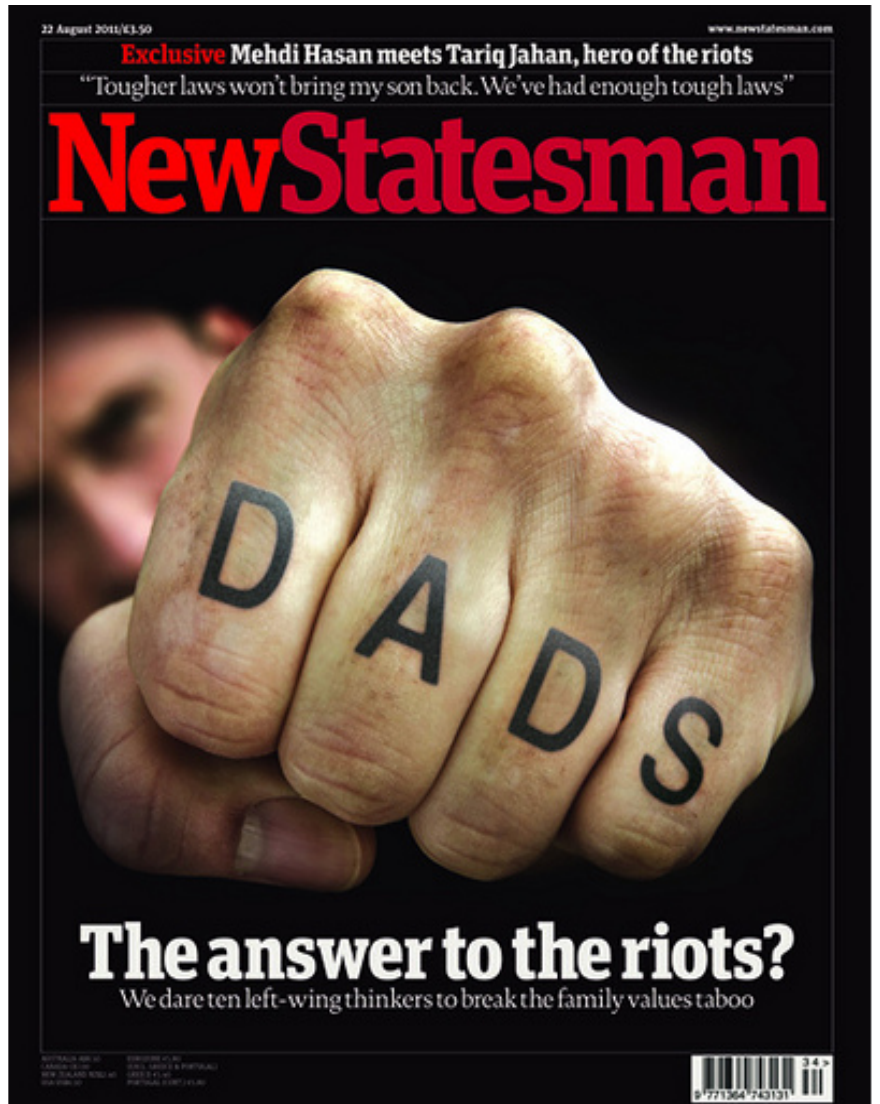
Image 1: Dads: The answer to the